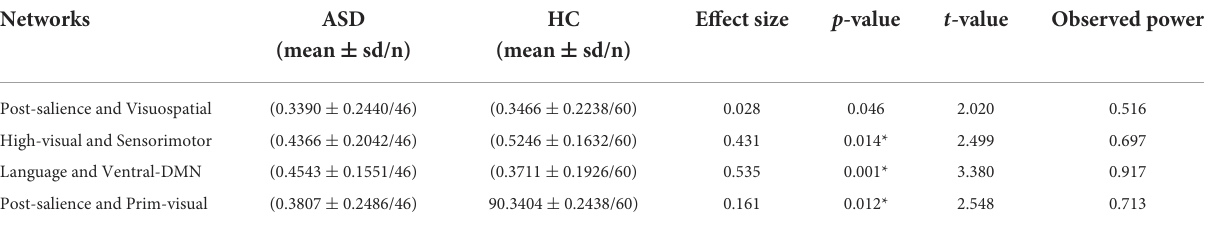
TABLE 2 Significant changes in interactions between brain functional networks in ASD as compared to HC based on Richiardi et al. parcellation method. Networks